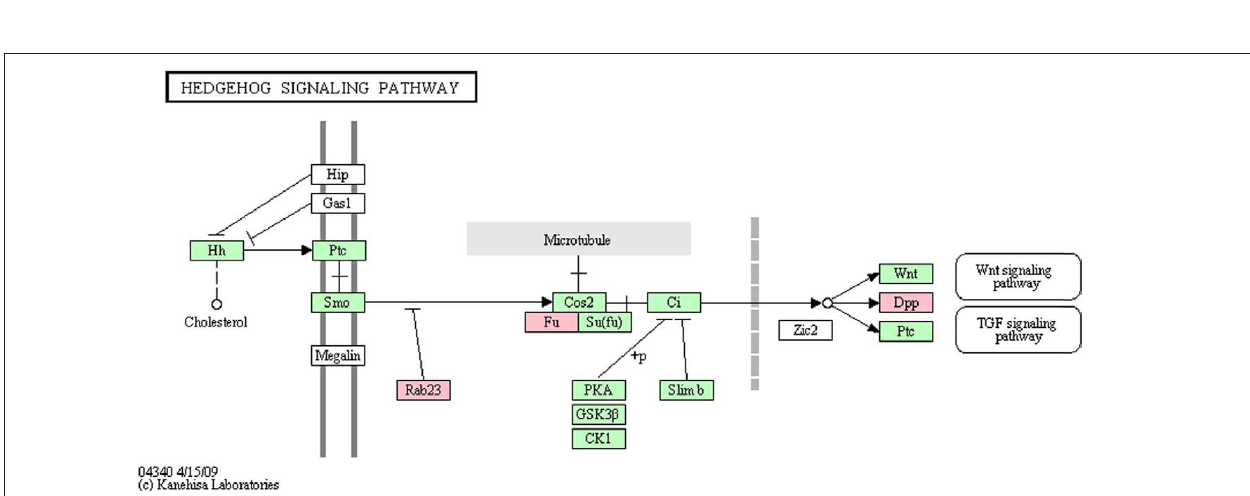
Figure 9 | genes mapping to Kegg pathway for endocytosis. Pink boxes represent upregulated genes in AED untreated flies. These genes are Gap69C (GTPase-activating protein 69C), Hsp68 (Heat shock protein 68), PIP5K59B (CG3682 gene product from transcript CG3682-RA), TSG101 (tumor suppressor